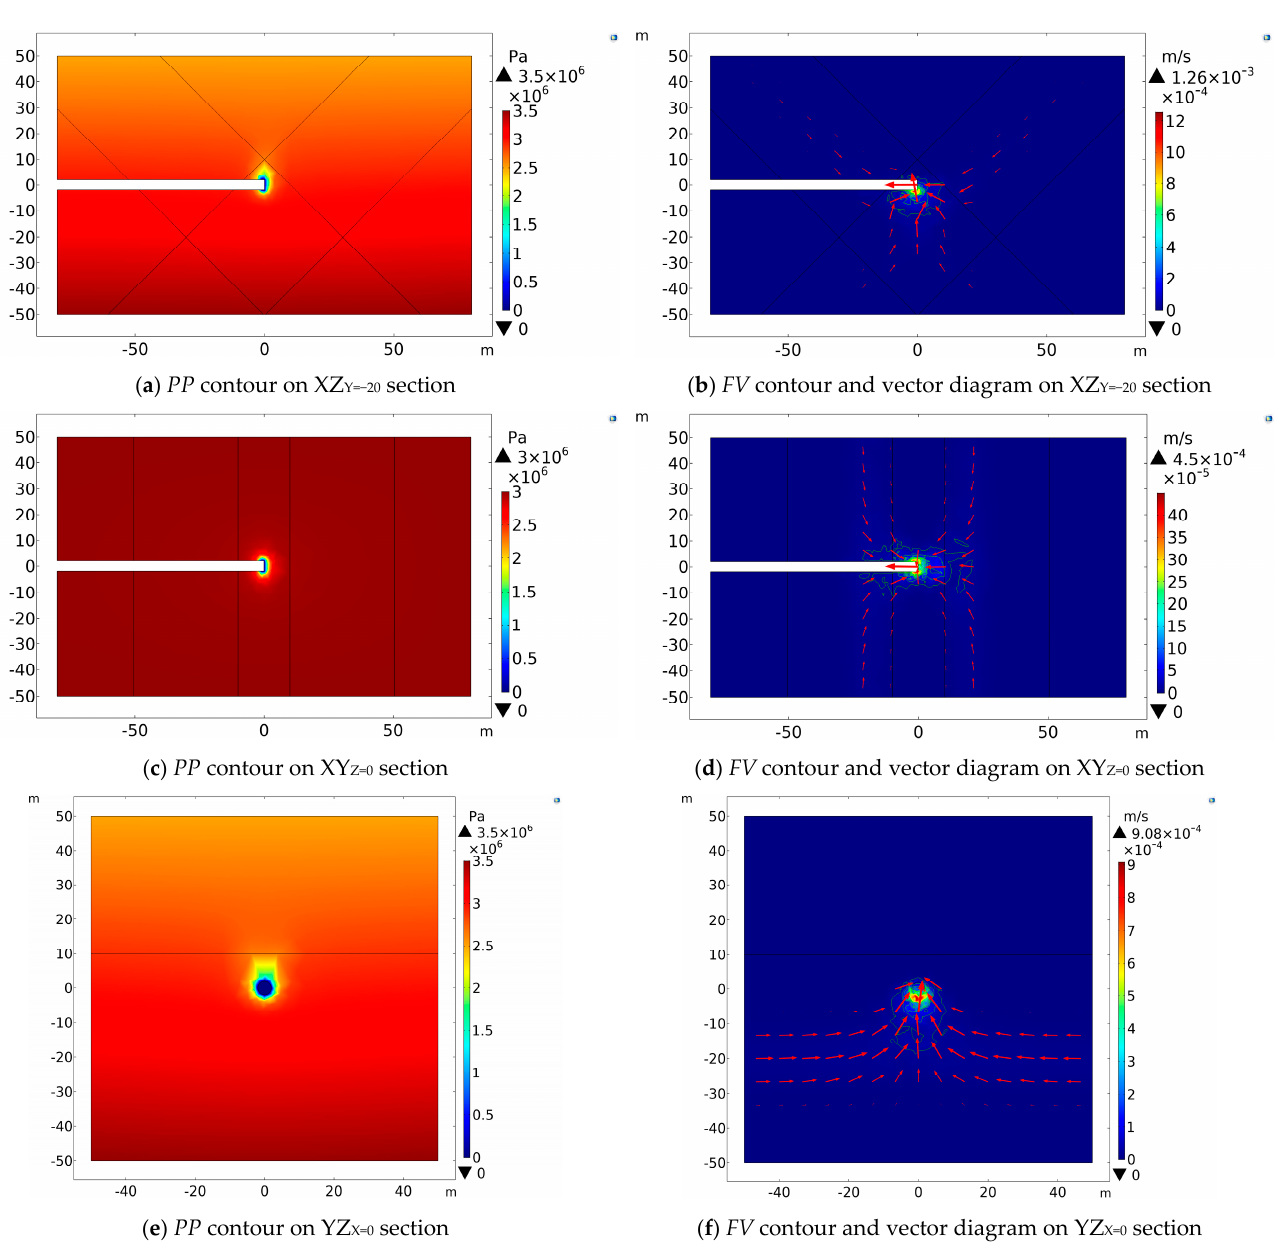
Figure 8 reveals PP and FV contours on various sections (XZ Y= − 20 , XY Z=0 , YZ X=0 ) while the tunnel is excavated to 20 m above the two intersecting faults (Y = − 20).